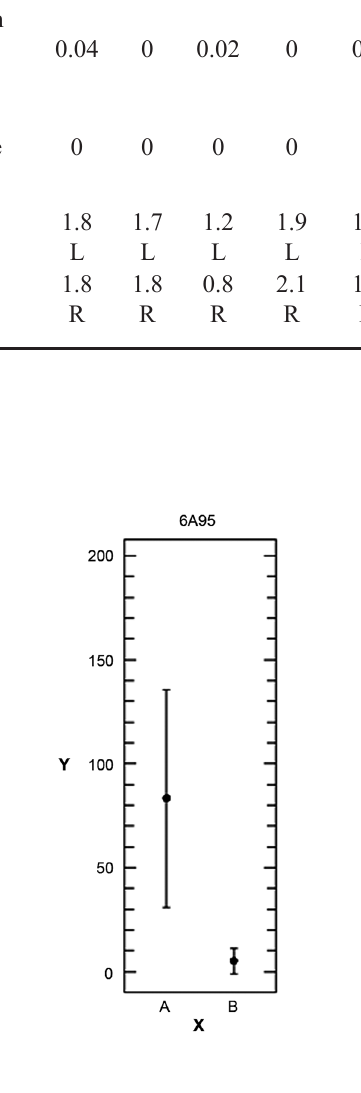
Figure 1 – Sperm concentration/ejaculate in Buserelin treated group (A) and untreated group (B) Mean and SD are demon- strated. Y = number of sperm in million per